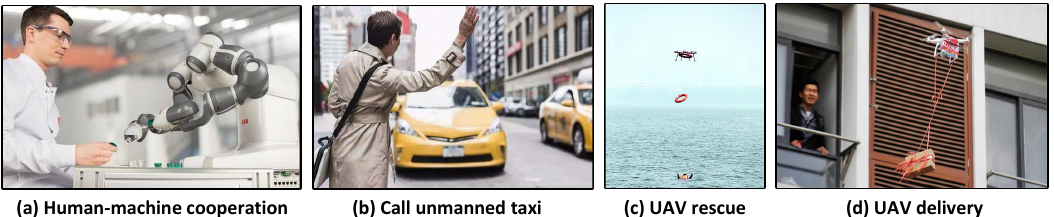
Figure 3. Gesture/Action recognition is the intuitive way for human-robot interaction under many